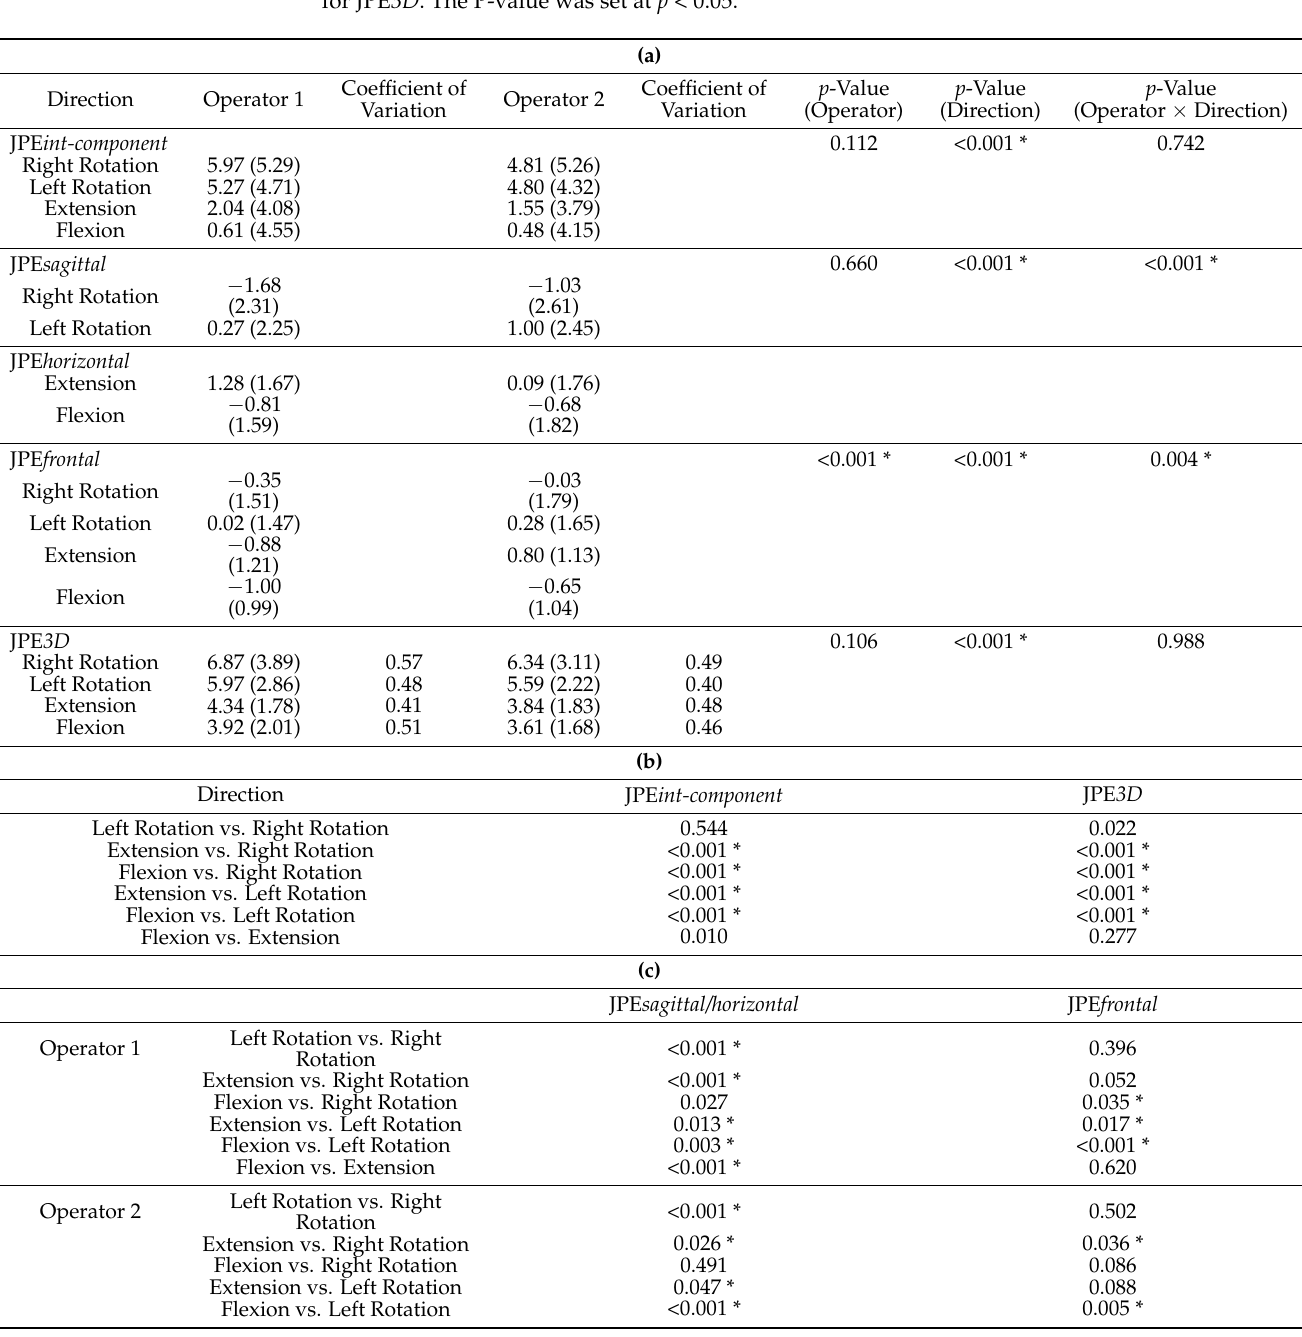
(b) Student’s t -test post hoc on contrasts between pairs for JPE intended and JPE 3D for the “Direction” factor. (c) Student’s t -test results on contrasts between pairs for JPE sagittal , JPE horizontal , and JPE frontal for “Operator × Direction” interaction factor. Coefficients of variation are presented only for JPE 3D . The P-value was set at p <